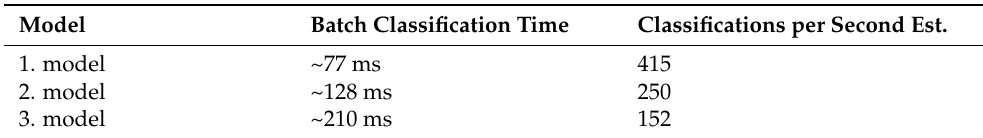
Table 8. The time needed for classification of one batch (32 signals) and estimated number of classifications per second.